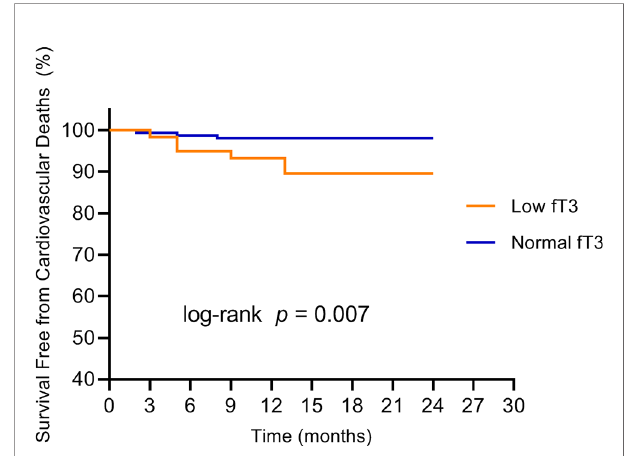
Normal coronary arteries (0% stenosis), n